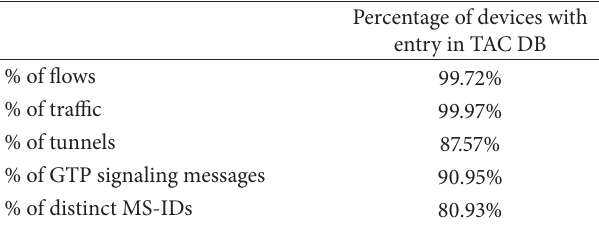
Table 1: Relative TAC